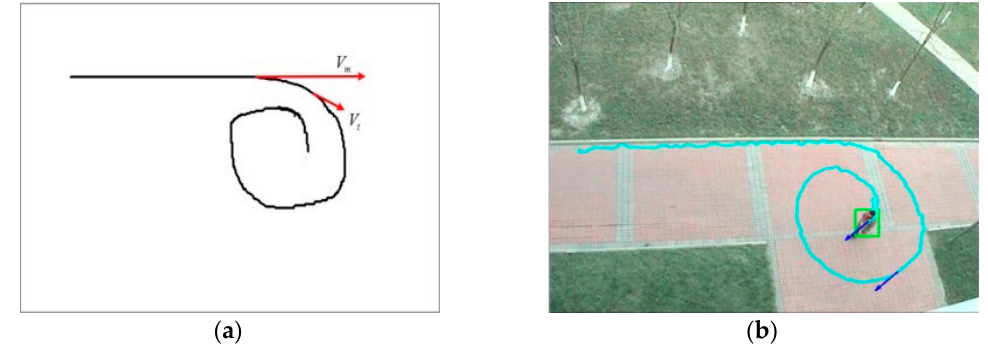
Figure 6. Motion trajectory. ( a )Trajectory models and ( b ) real trajectory.